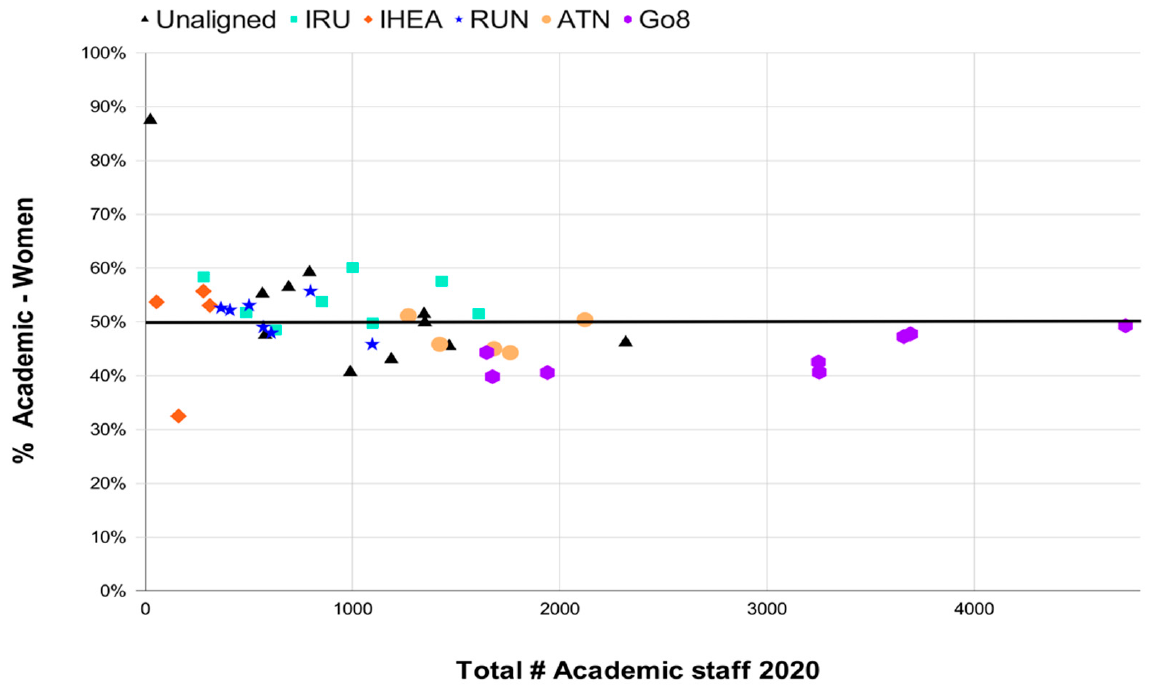
Figure 5. Percentages of women academic staff (headcount) compared to the total number of academics in the institution for 43 Australian universities by grouping, 2020. The full file is available at https://doi.org/10.5281/zenodo.6500293 (accessed on 24 June 2022). Data source: Department of Education, Skills and Employment. Image: Curtin Open Knowledge Initiative.